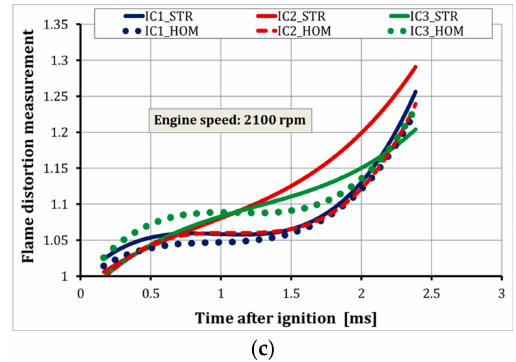
Figure 9. Flame distortion level at specific engine speeds for stratified and homogeneous combustions